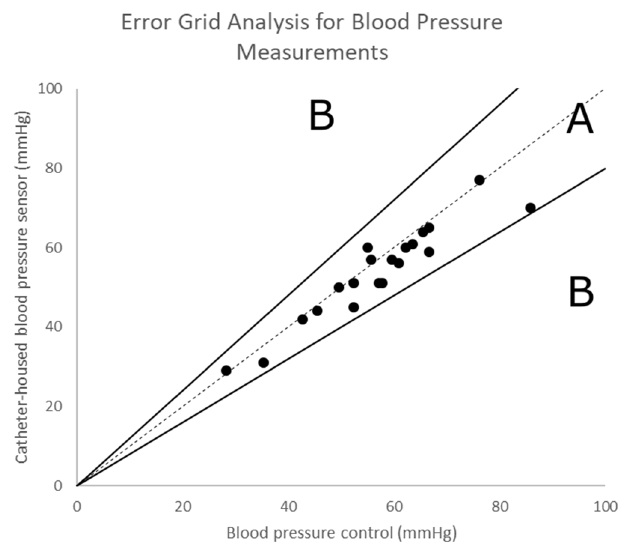
Figure 3. Error grid analysis of the blood pressure measured from the NO-releasing catheter with integrated lactate sensors implanted in the femoral arteries, compared to the control measured though an FDA-approved cannula implanted in another femoral artery. Zone A denotes accurate pressure measurements falling within 20% of error compared to the control. We used Clarke’s error grid analysis, which is typically used to quantify the clinical accuracy of blood sensors [70].